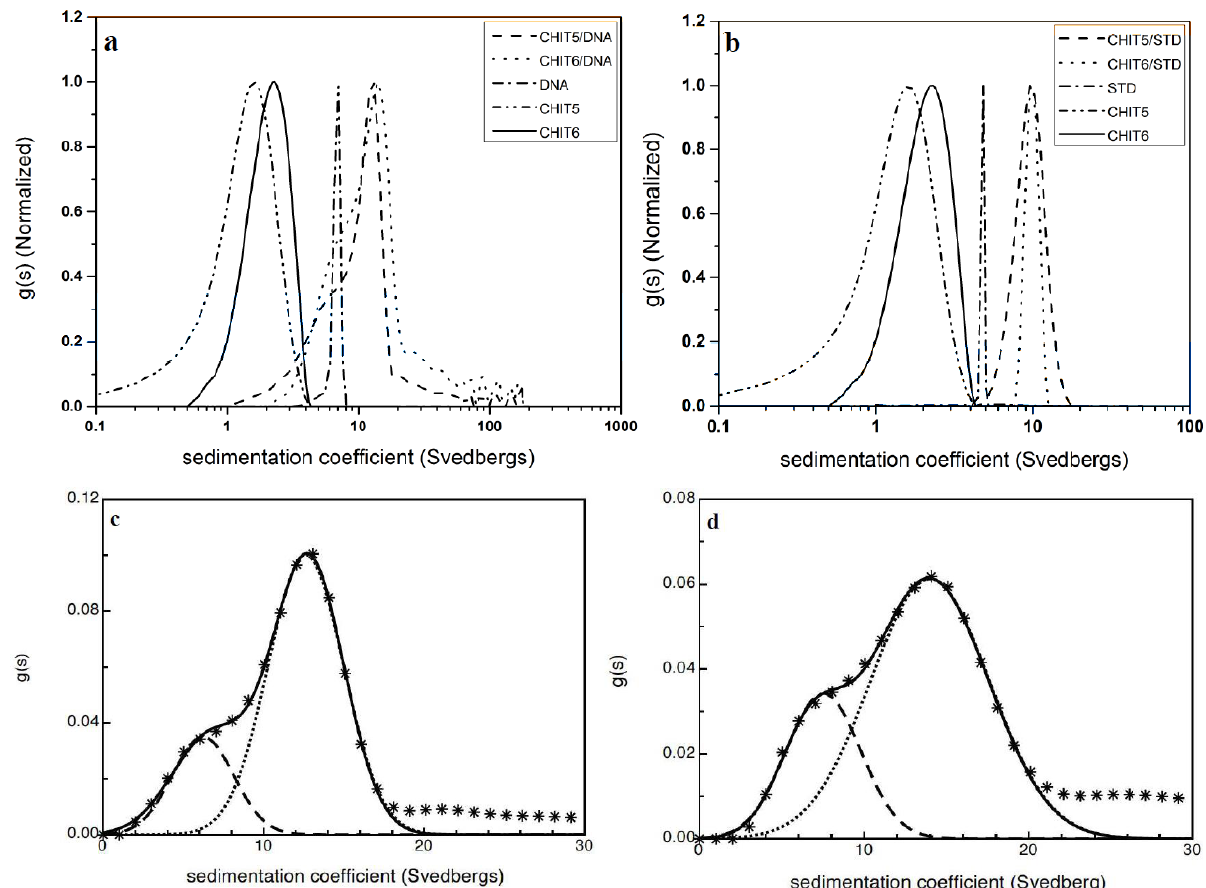
Figure 4 . Normalized sedimentation coefficient distribution profiles obtained from sedimentation velocity experiments for unmixed controls and mixtures ( a ) chitosan with DNA; ( b ) chitosan with xanthan-STD; ( c ) multi-Gaussian fit to the CHIT5-DNA mixture; ( d ) multi-Gaussian fit to the CHIT6-DNA mixture. Reproduced from [25] with permission from